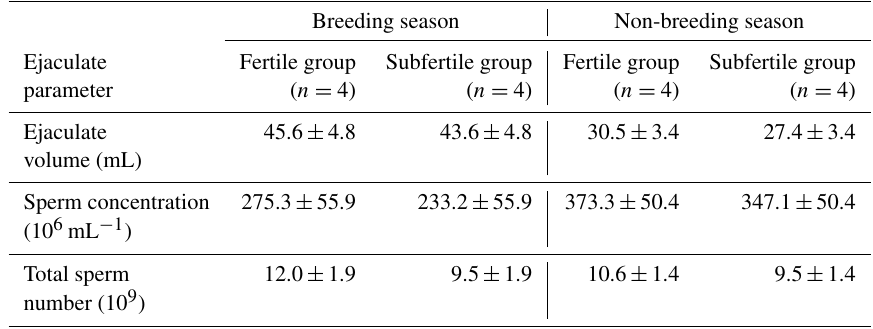
Table 1. Ejaculate volume, sperm concentration, and total sperm number of chilled semen collected from fertile and subfertile stallions during breeding and non-breeding season (least-square means ± SE).